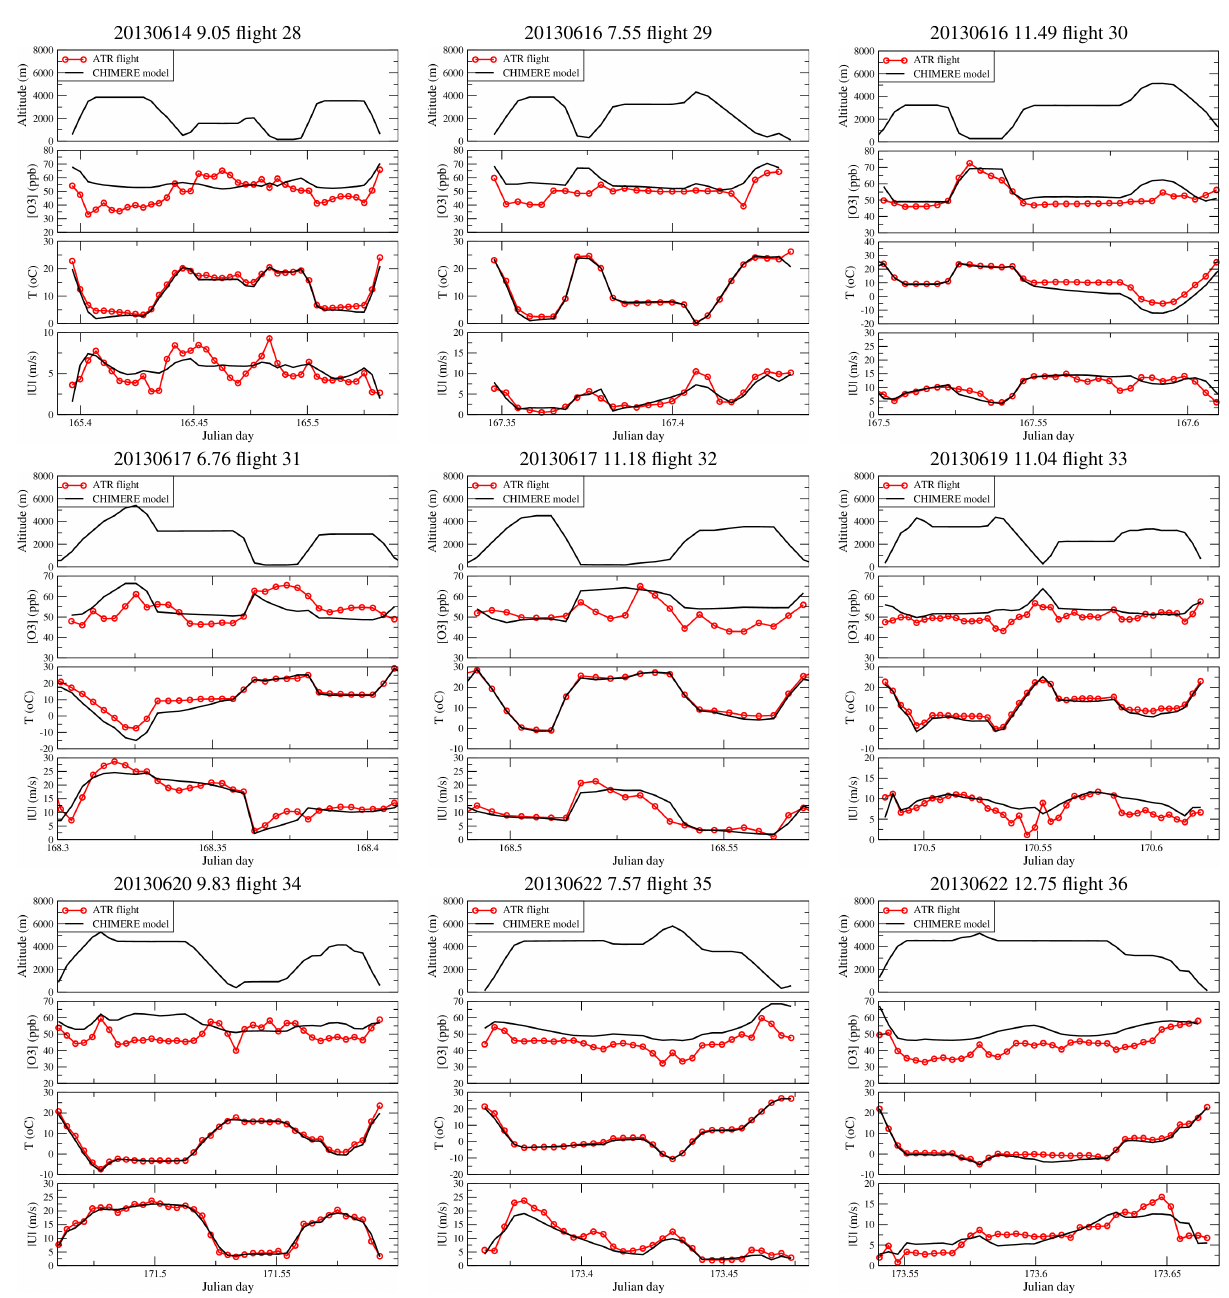
Figure 12. Comparisons between observed and modeled O 3 concentrations, temperature and wind speed along the flight trajectories. The top plot indicates the altitude above sea level of the flight. The abscissa represents the day of the